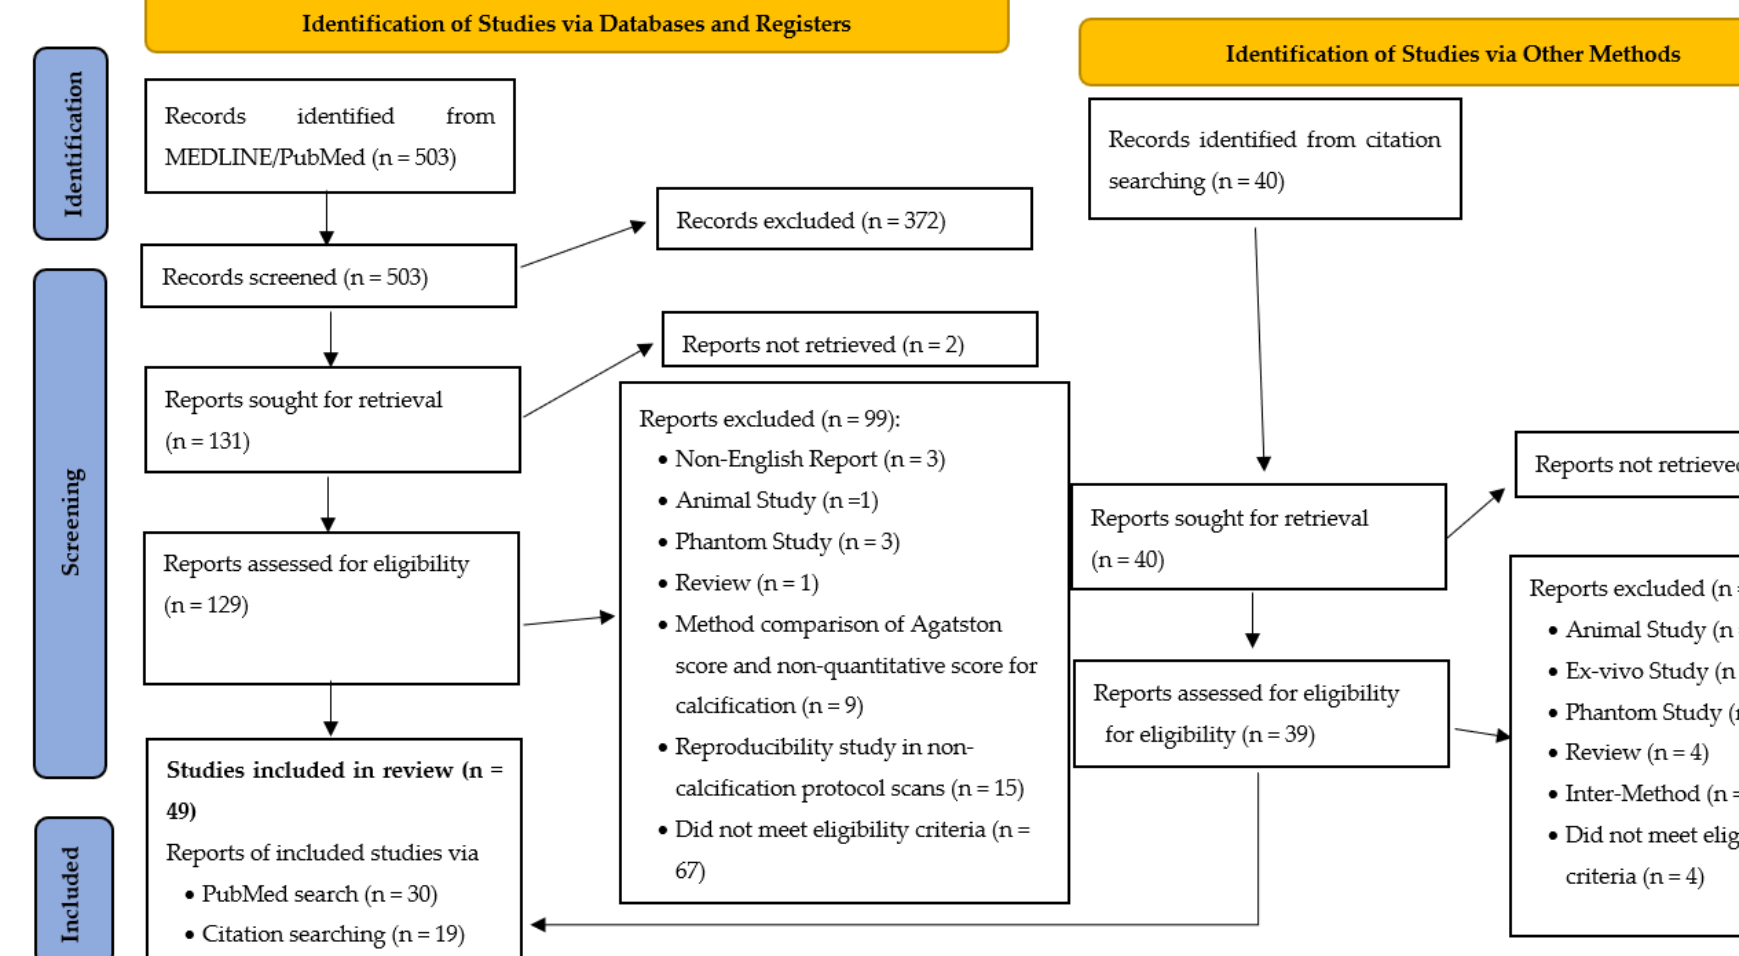
Figure A1. PRISMA flowchart [10].